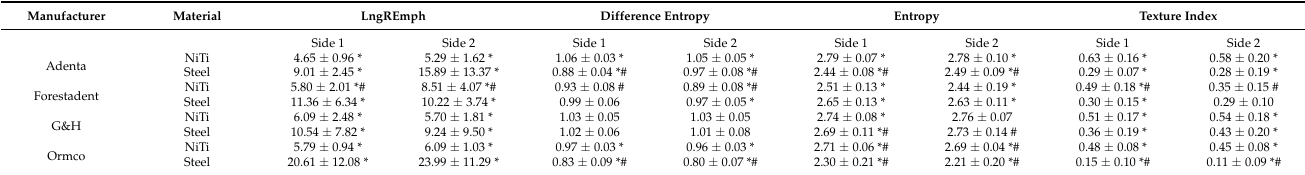
Table 3. Comparison of the surface texture of archwires.